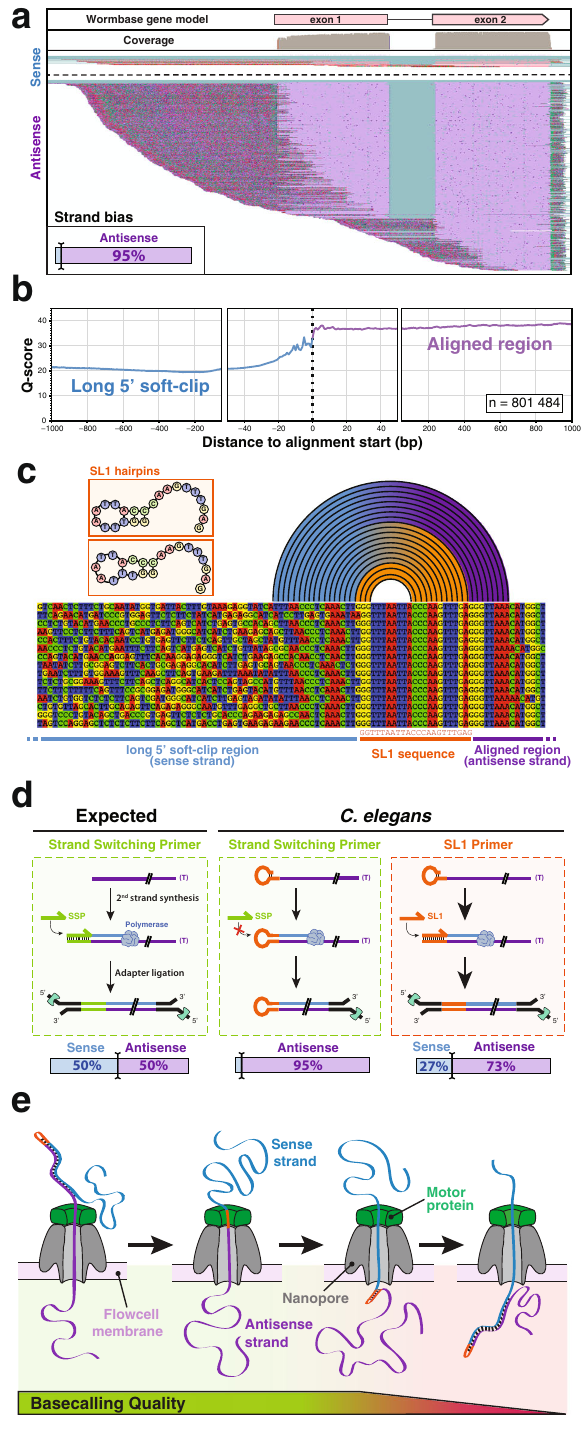
intermediate between the two, and splicing of the SL to the fi rst exon mRNA is called the outron 6 .